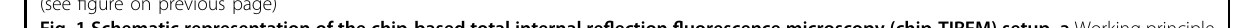
(Fig. 1d), enabling the acquisition of images over large fi elds of view 26 (Fig. 1e), a feature not available in conventional TIRFM setups.